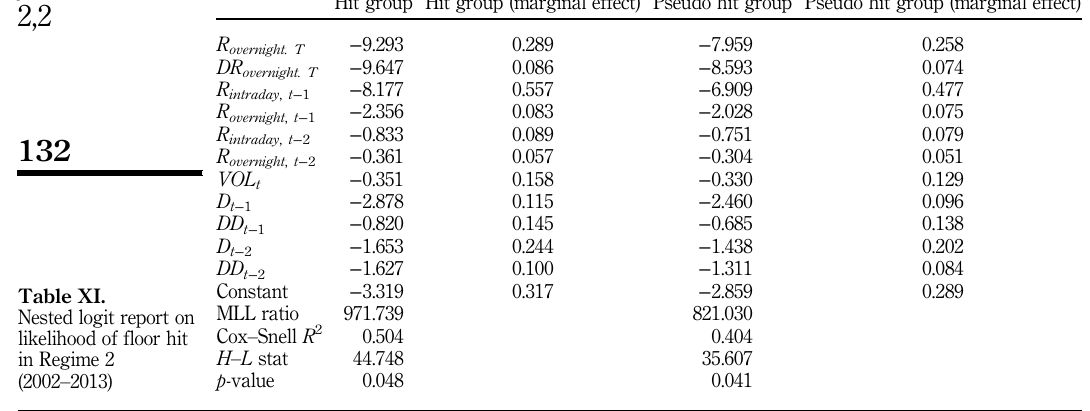
Table XI. Nested logit report on likelihood of floor hit in Regime